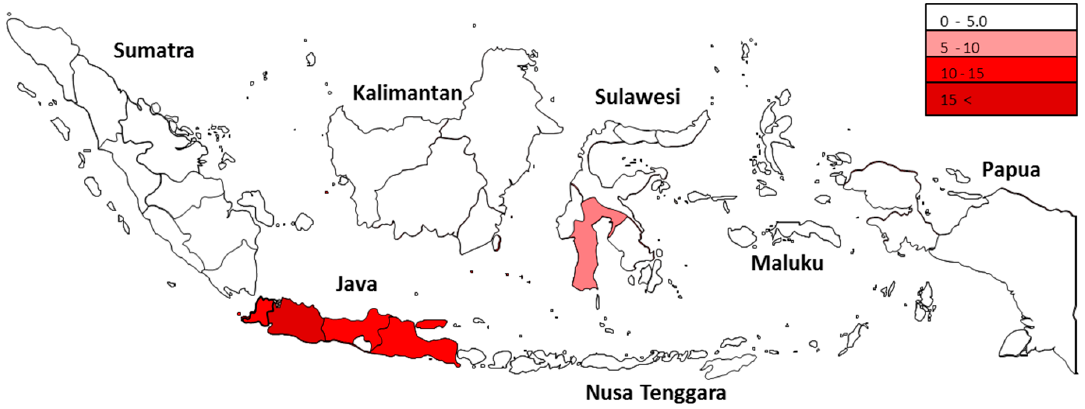
Figure 16. CO 2 emissions disparities among provinces, BAU scenario, 2050 (million ton CO 2 ).